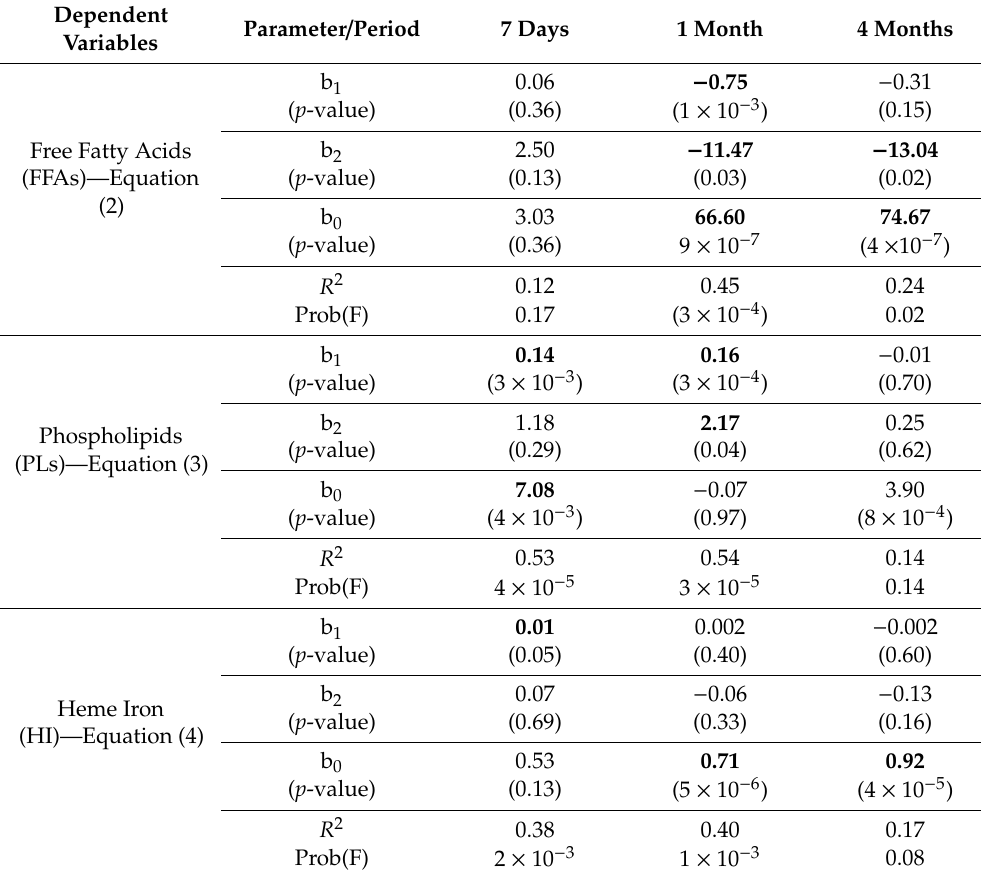
Table 2. The regression model estimates. Significant parameter values (with p < 0.05) are shown in